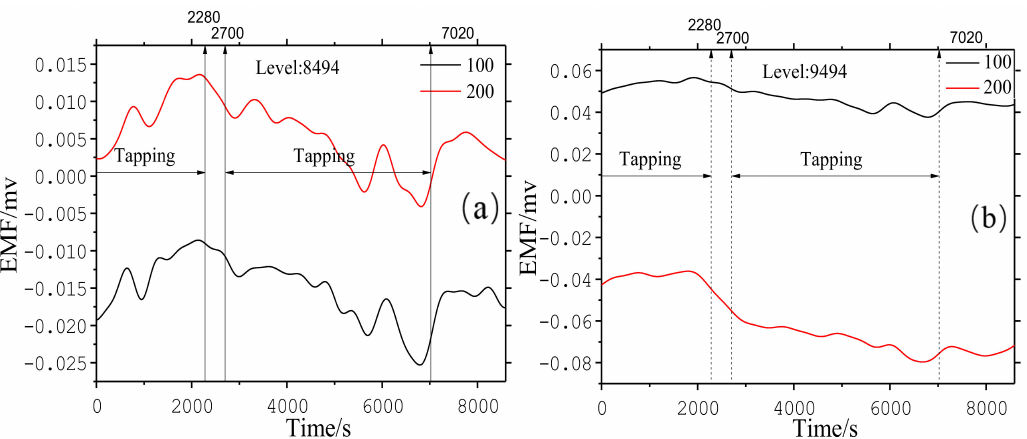
Figure 12. EMF signals of blast furnace hearths: ( a ) EMF signals on the “2” direction at the 8494 level and ( b ) EMF signal on the “2” direction (C.F. Figure 7) at the 9494